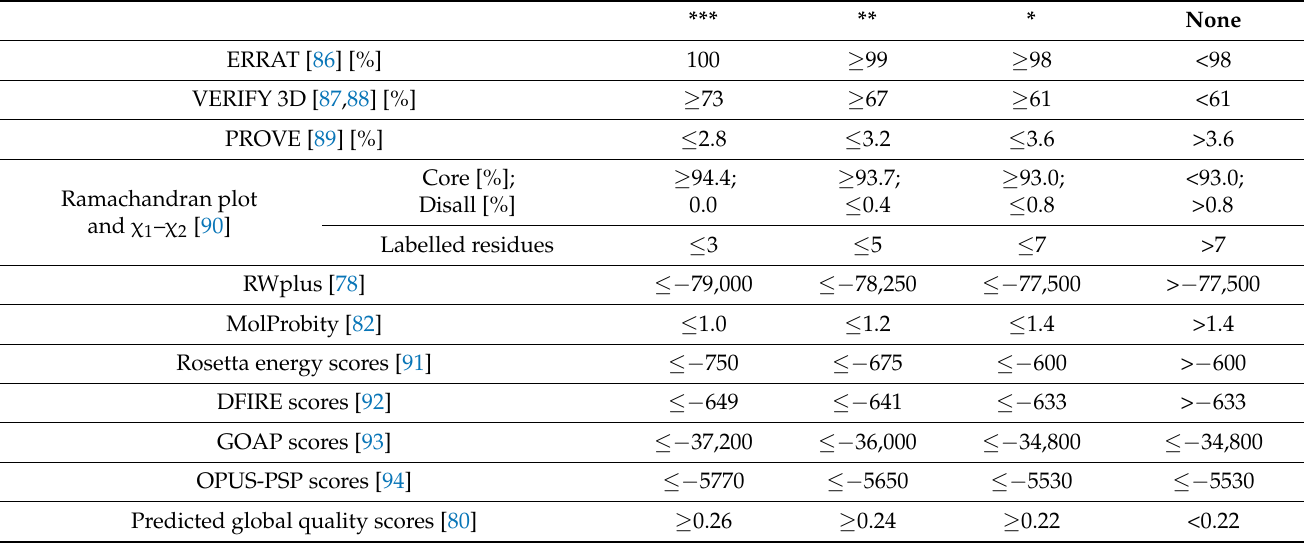
Table 3. Assigned stars value ranges of individual protein global quality functions, for the models after optimization with DeepRefiner Webserver